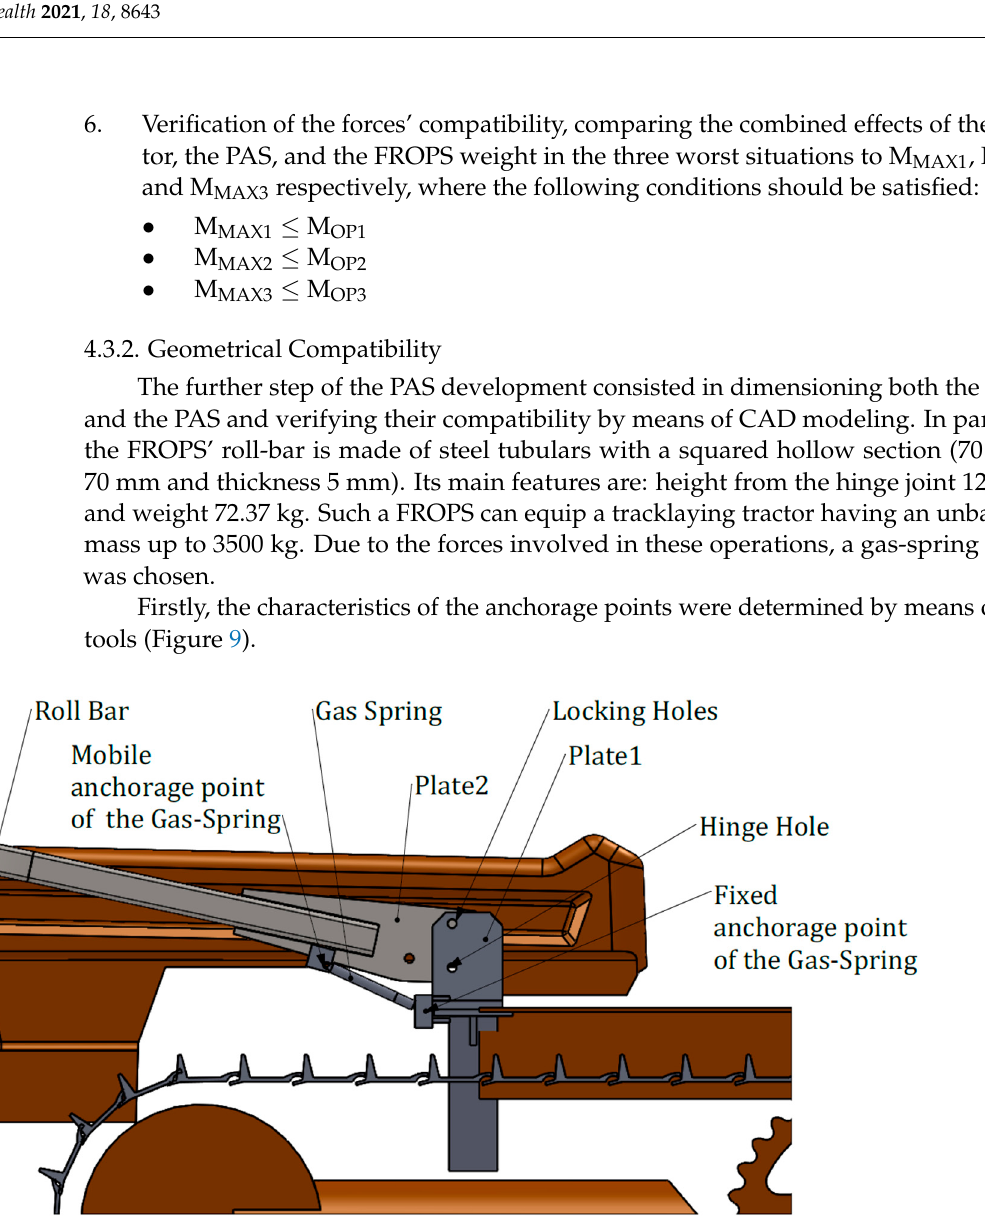
Figure 9. Features of the anchorage points of the PAS (lateral